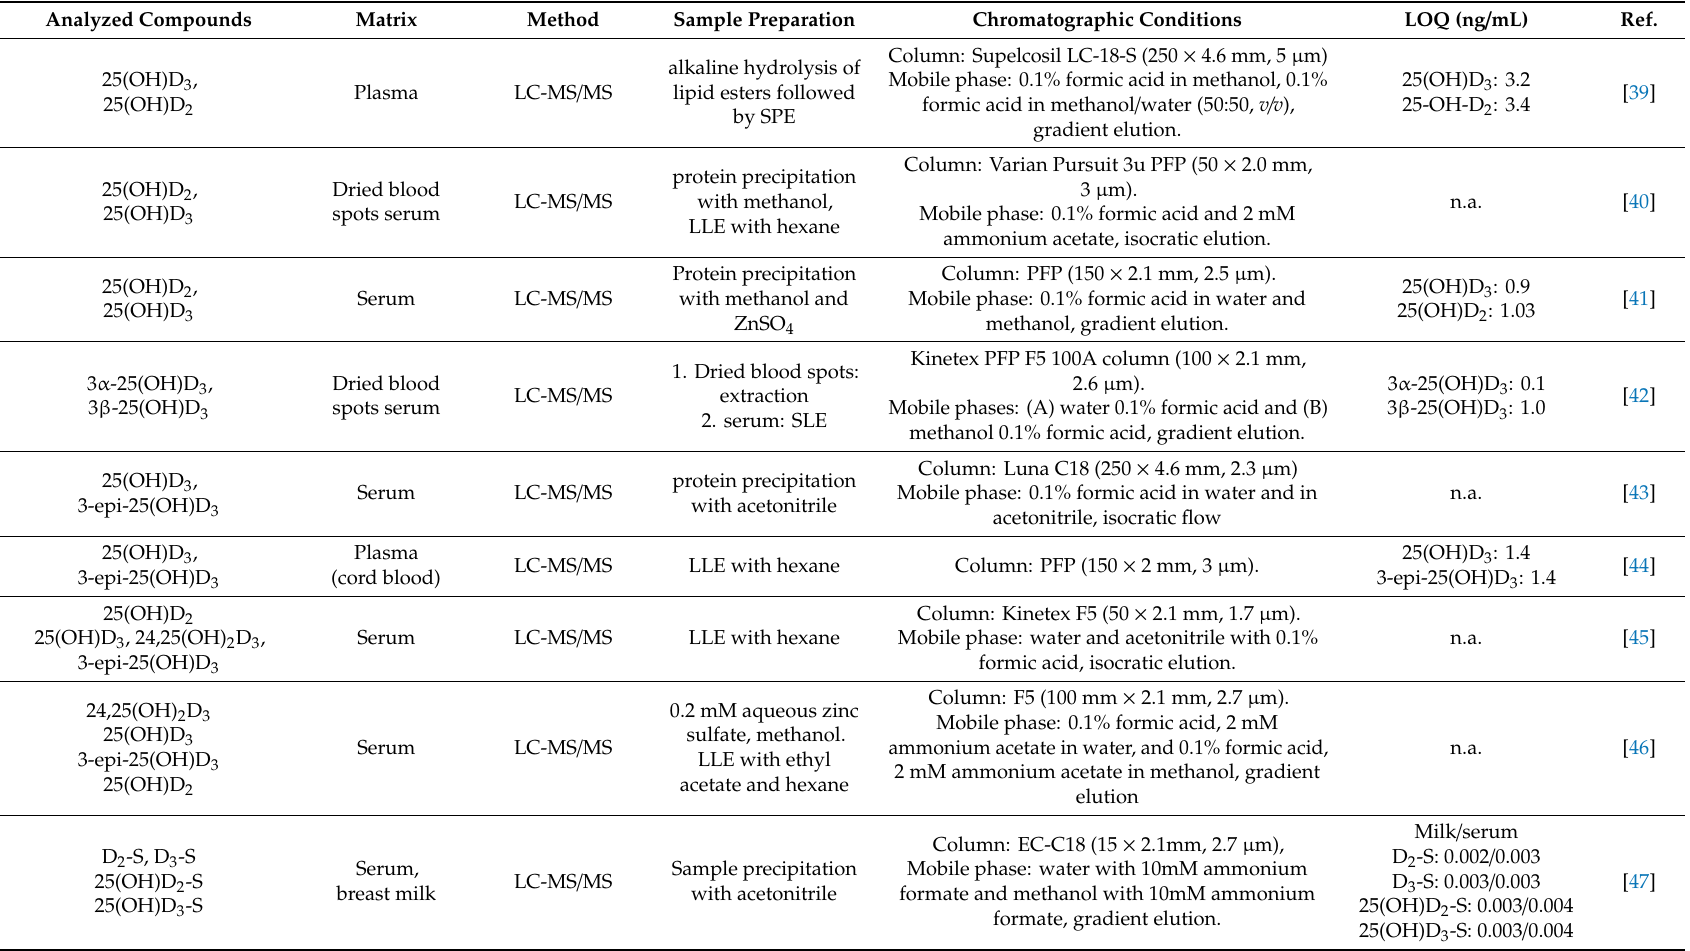
Table 1. Recent liquid chromatography coupled with tandem mass spectrometry (LC-MS / MS) methods for analysis of forms and metabolites of vitamin D. Analyzed